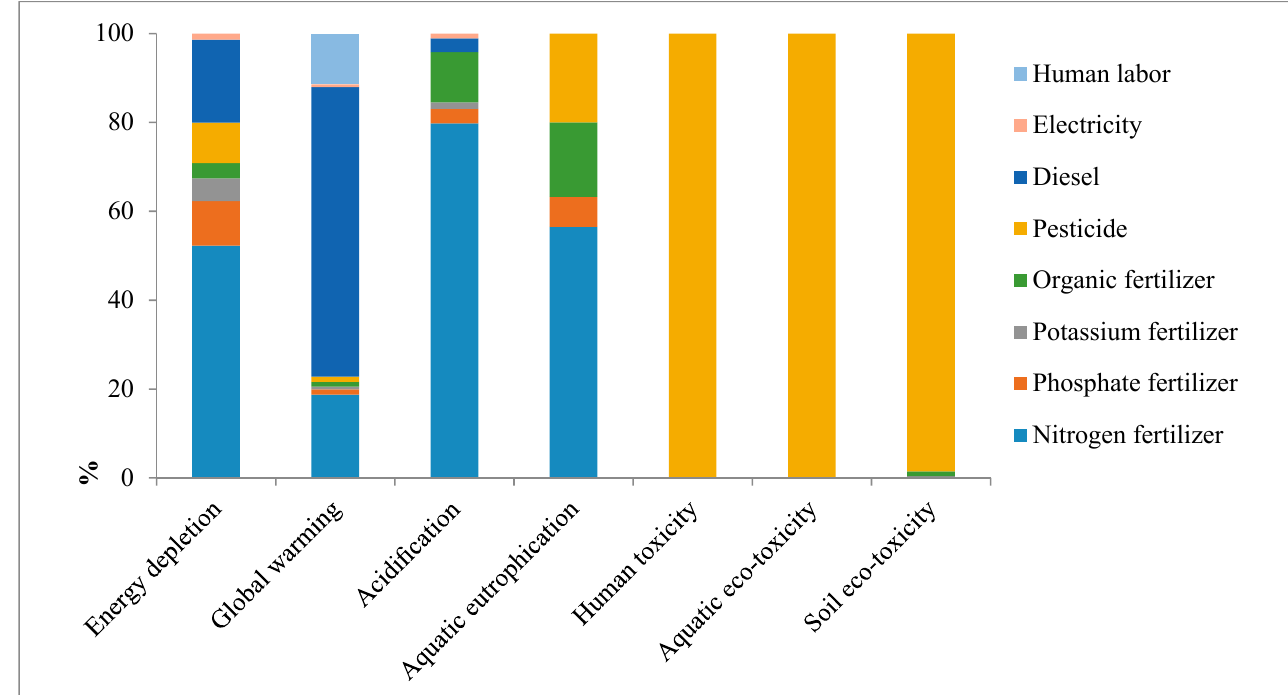
Figure 3. Contribution of agricultural material inputs to each environmental impact potential for the cooperatives.